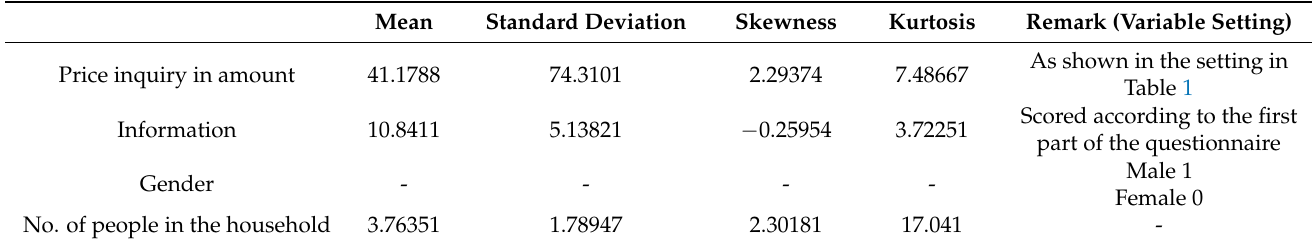
Table 5. Descriptive statistics of questionnaire empirical